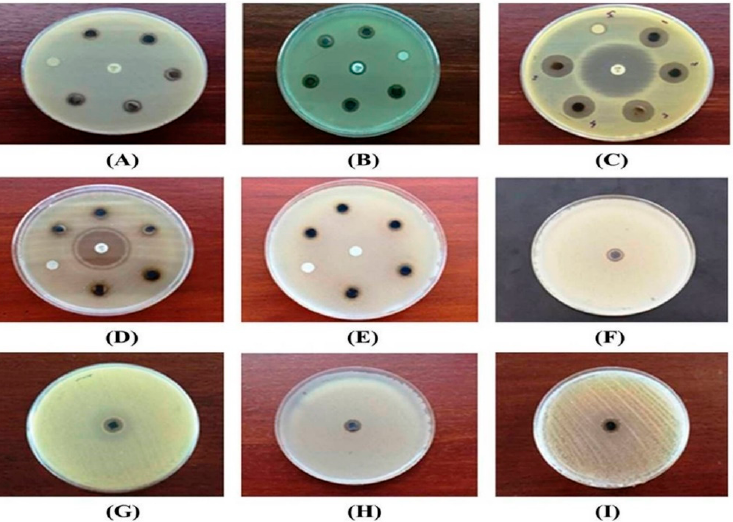
Figure 8. Antimicrobial activity of Eh-AgNPs against ( A ) B . cereus (ATCC 10876), ( B ) S. aureus subsp. aureus (ATCC 11632), ( C ) E. coli (ATCC 10536), ( D ) P . aeruginosa (ATCC 10145), ( E ) C. albicans (ATCC 10231), ( F ) MDR S . pneumoniae (ATCC 700677), ( G) MDR E. faecium (ATCC 700221), ( H ) MDR S . aureus subsp. aureus (ATCC 33592), and ( I ) MDR E . coli (NCTC 13351). Table 2. Antimicrobial activity of the synthesized AgNPs against pathogenic and MDR microbes. Microbes